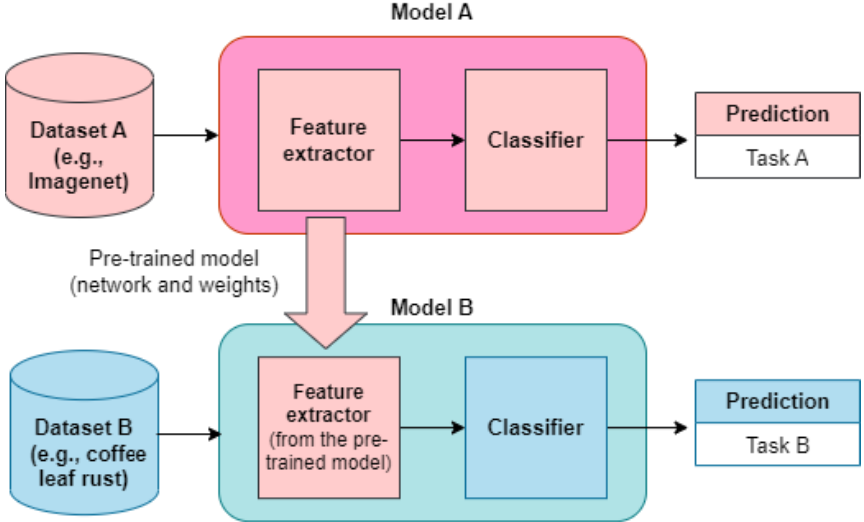
Figure 1. Schematic representation of transfer learning. Typically, dataset B is much smaller than dataset A. The classifier block contains new fully-connected (FC) layers and the output of the